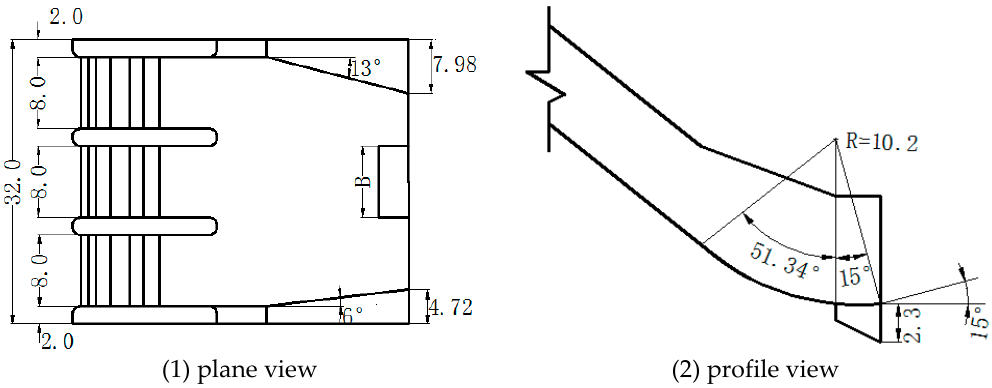
Figure 8. Geometrical configuration of the swallow-tailed bucket (unit: m). Table 4. Designed schemes for the swallow-tailed bucket.